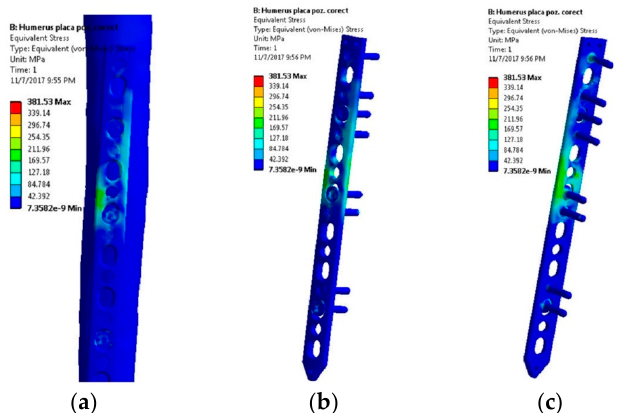
Figure 7. Stress distribution within the LCP when a 10 kg mass is lifted—abduction movement